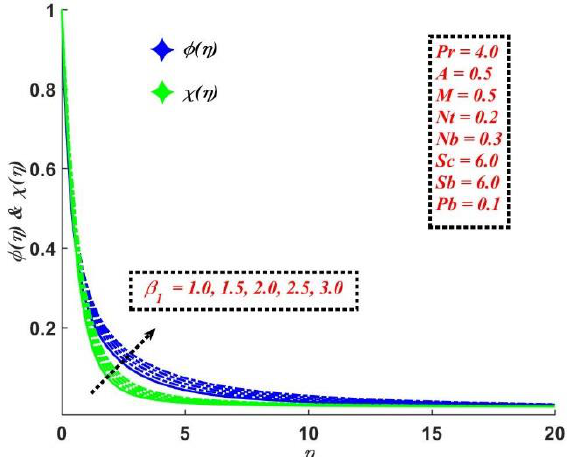
Figure 7. Influence of the slip parameter on 𝜙(𝜂) and 𝜒(𝜂) .